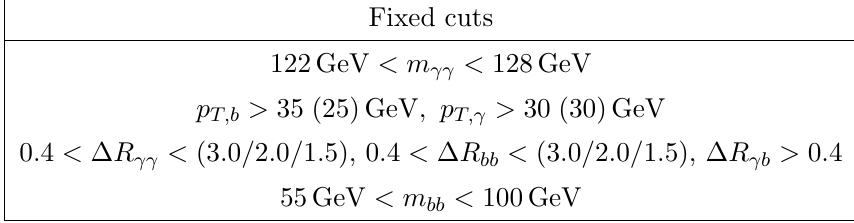
Table 5 . Applied (cid:12)xed cuts for the cut-based